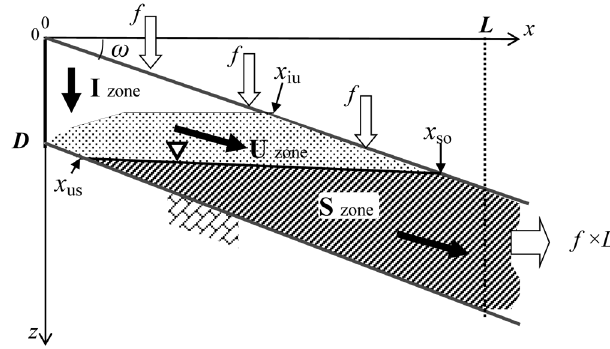
Fig. 5. Schematic of a sloping permeable domain with approximate categorisation of the pressure head (I, U, and S zones). The horizon- tal distances involving the categorisation of x iu , x us , and x so are also